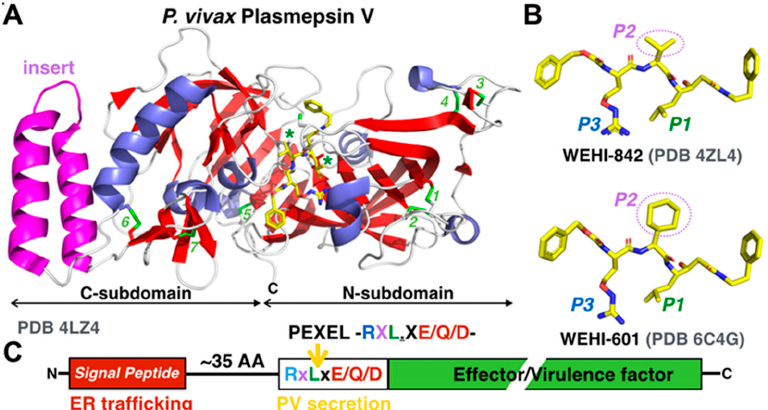
Figure 9 . Inhibitors of the licensing aspartic protease plasmepsin V mimic the PEXEL vacuolar